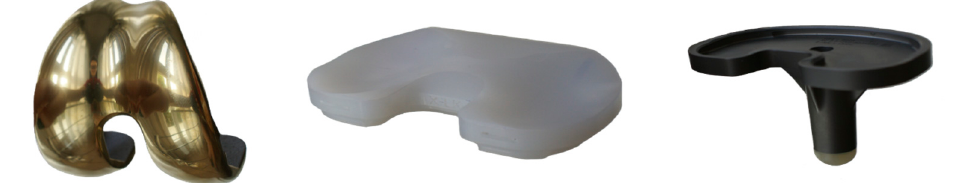
Figure 1 . Some parts of cemented knee prothesis, from left to right: femoral compo- Figure 1. Some parts of cemented knee prothesis, from left to right: femoral component, polyethylene, nent, polyethylene, tibia component [31]. tibia component